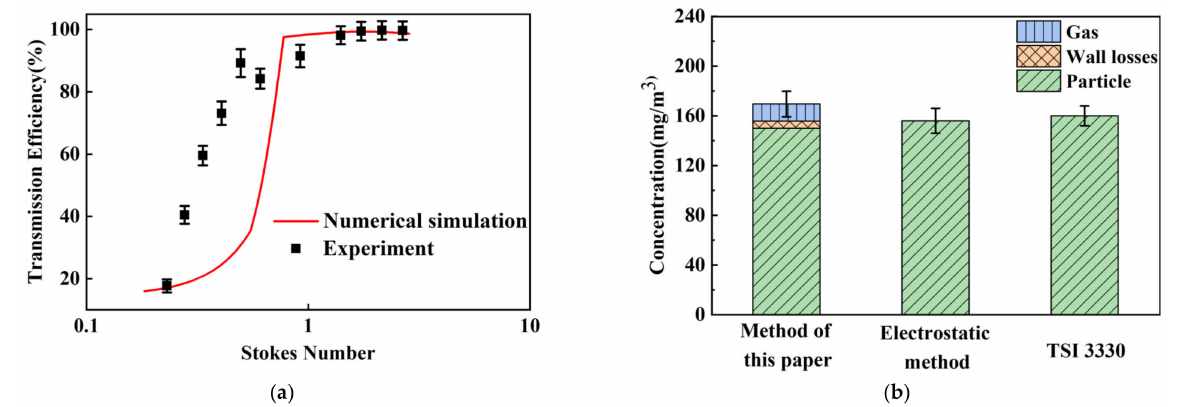
Figure 11. ( a ) Comparison of the experimental and simulation results for the sampler (the number of experiments is 3). ( b ) comparison of results measured by different oil mist sampling methods (the number of experiments is